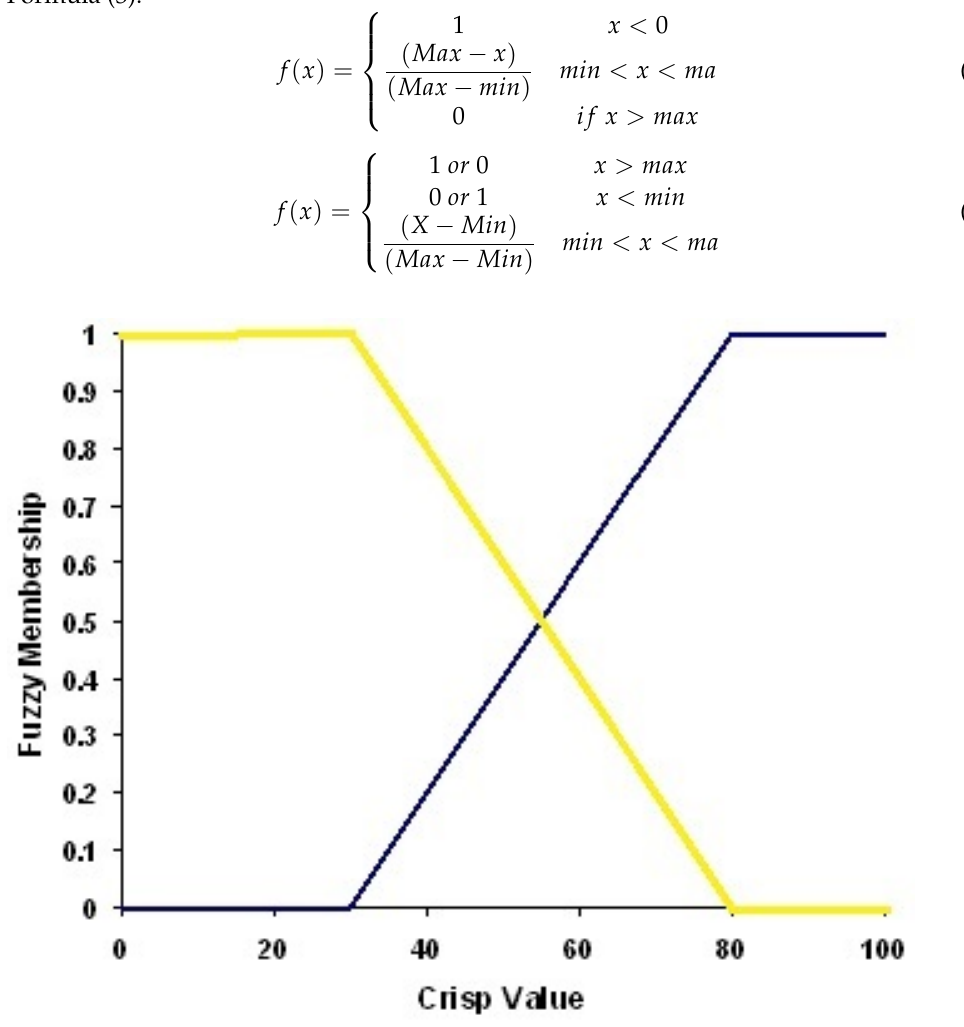
Figure 5. The yellow line represents a negative FLM function based on Formula (2), whilst the blue line represents a positive FLM function based on Formula (3).